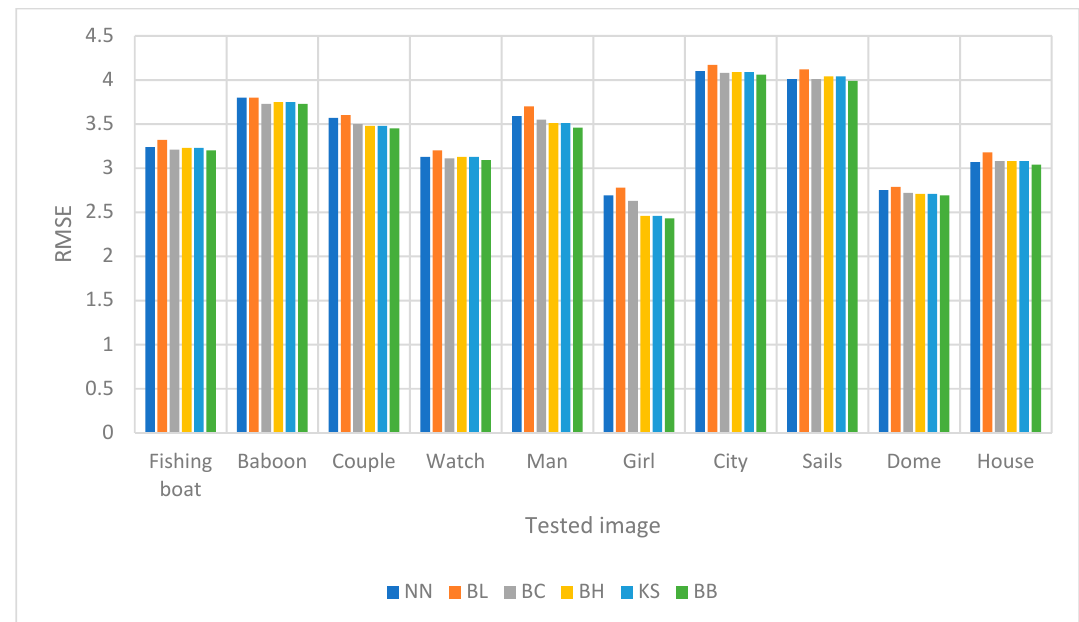
Figure 9. A comparison of schemes toward RMSE for image upscaling with a factor of two.